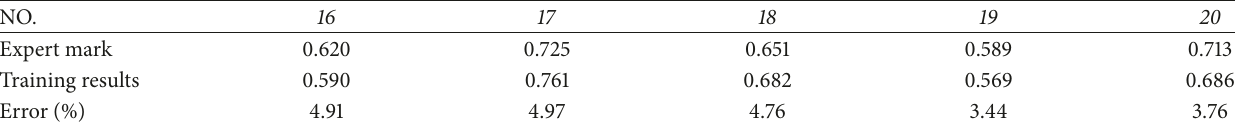
Table 11: Validation results of BP neural network on construction risk of railways in 5 European countries.